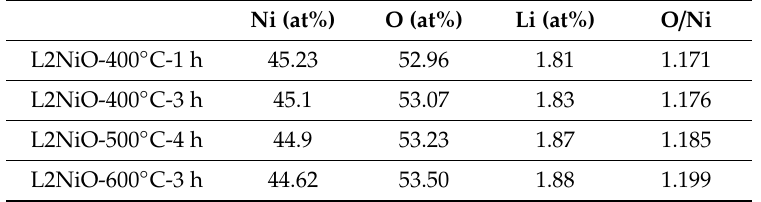
Table 2. Elements of L2NiO thin films as a function of annealing temperature and time. Ni (at%) O